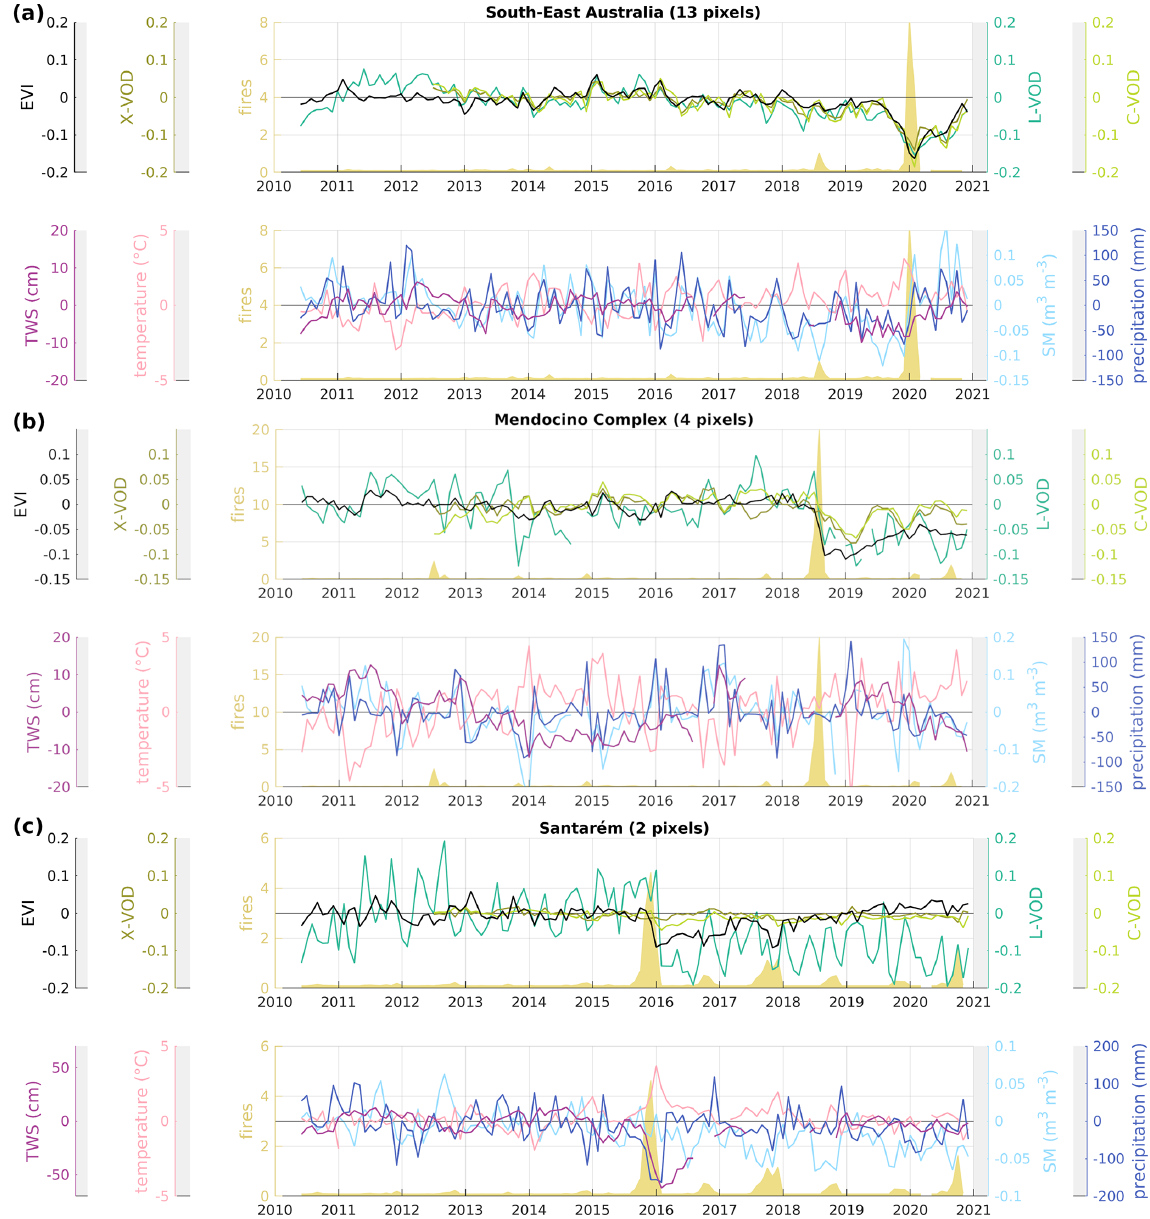
Figure 4. Time series of the number of fires and anomaly time series of EVI; X-, C-, and L-VOD; P ; SM; TWS; and T for (a) south-east Australia (13 SMOS pixels); (b) the Mendocino Complex, California (4 SMOS pixels); and (c) Santarém (2 SMOS pixels).